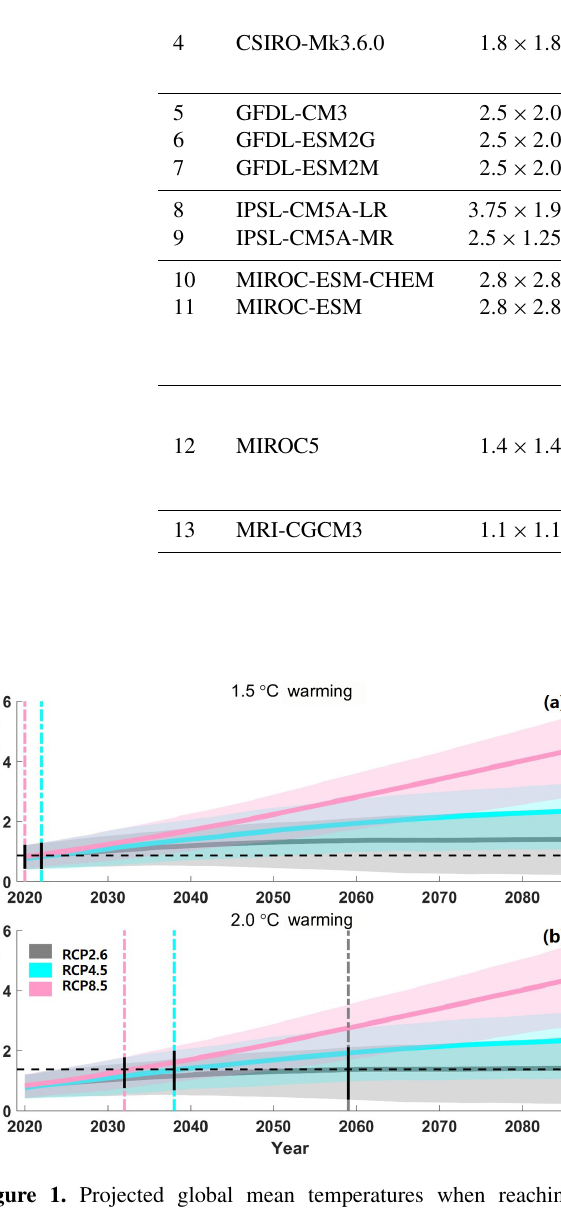
Figure 1. Projected global mean temperatures when reaching 1.5 and 2.0 ◦ C